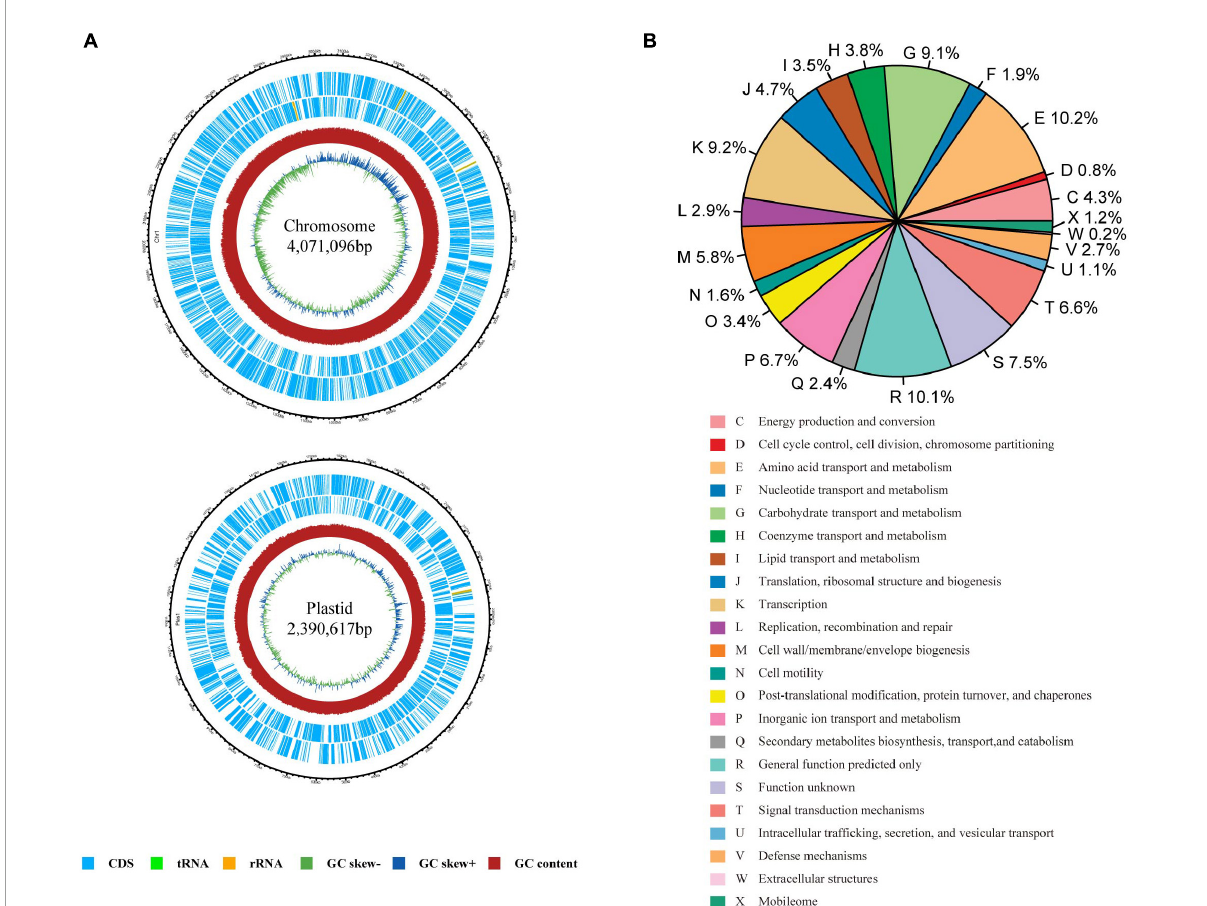
FIGURE1 Genome characteristics of Rhizobium sp. CACMS001. (A) Graphical genetic features of Rhizobium sp. CACMS001. From outside to the center: genes on the forward strand, genes on the reverse strand, G+C content, and GC skew. (B) The relative proportion of Rhizobium sp. CACMS001 genes in 22 COG